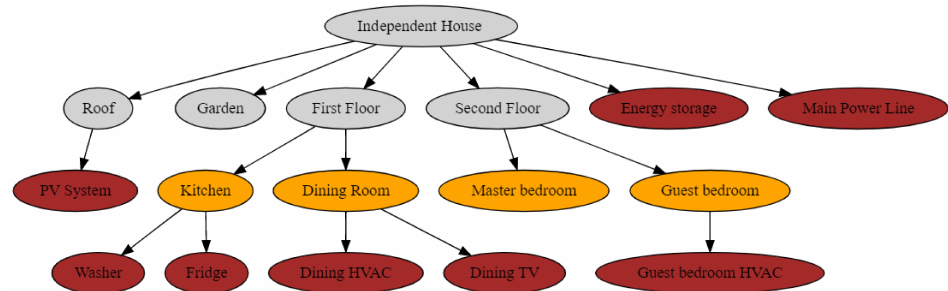
Figure 8. Topology of Independent House.